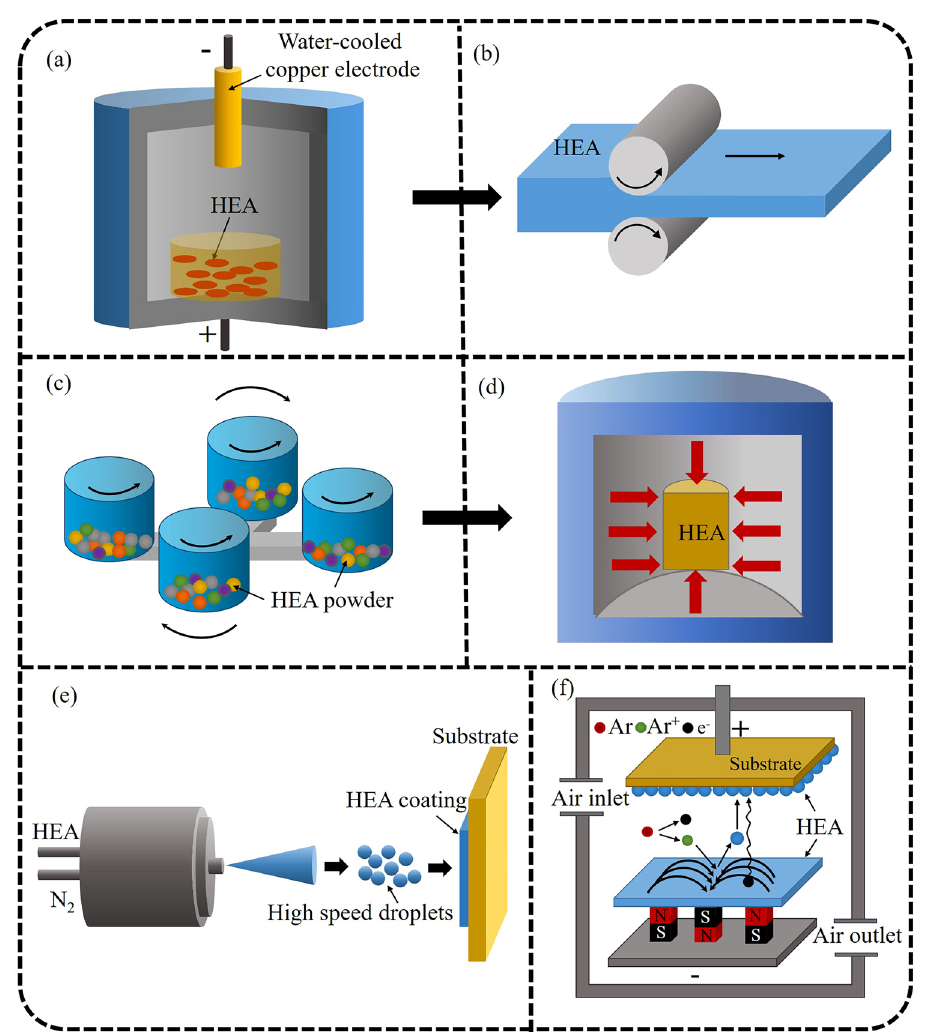
Figure 1: Schematic diagram of the preparation method of HEAs: ( a ) arc melting, ( b ) rolling, ( c ) mechanical alloying, ( d ) sintering, ( e ) spraying, and ( f ) magnetron